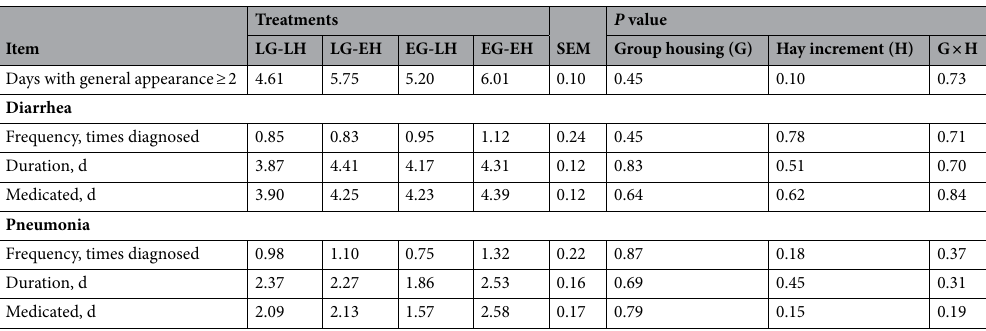
Table 4. Poisson regression for days with general appearance ≥ 2, a frequency and duration of diarrhea ≥ 3, b pneumonia, and days medicated during the overall (week 1–13) period as influenced by treatments containing age at group housing [G; late grouping (LG) vs. early grouping (EG)] and age at incremental hay supplementation [late hay increment (LH) vs. early hay increment (EH)]. a 1 = normal and alert; 2 = ears drooped; 3 = head and ears drooped, dull eyes, slightly lethargic; 4 = head and ears drooped, dull eyes, lethargic; 5 = severely lethargic 45 . b 1 = normal; 2 = soft to loose; 3 = loose to watery; 4 = watery, mucous, and slightly bloody; 5 = watery, mucous, and bloody.